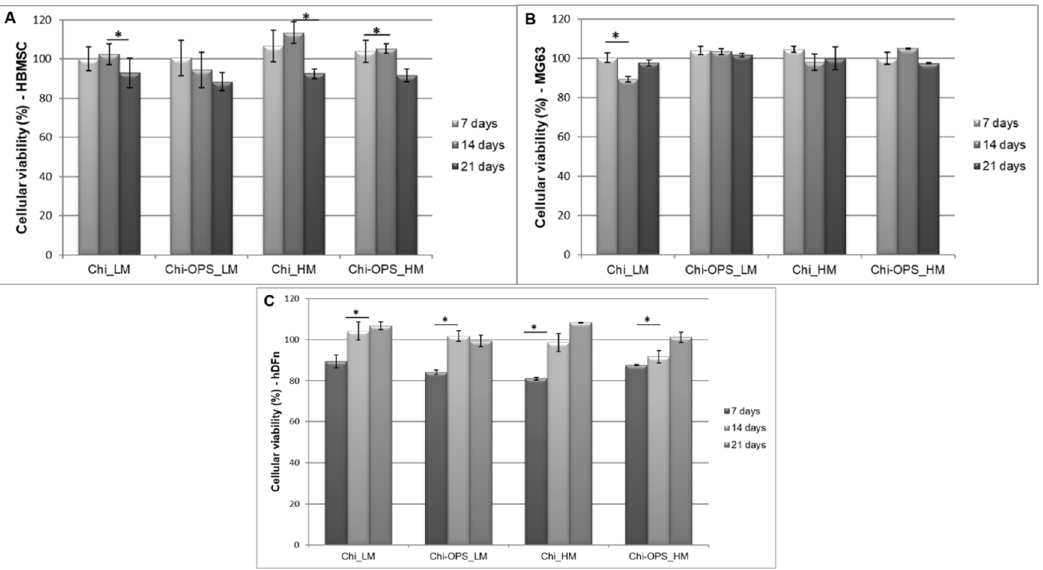
Figure 3. Fluorescent responses of primary cells cultured (HBMSC— A ), and both cell line cultured (MG63— B and HDFn— C ) incubated with CdS QD_Chi and QD_Chi–OPS (LM and HM) nanoparticles associated with the cellular metabolic. Cell culture control (TCPS) = 100%. Statistical analysis by one-way ANOVA, * p < 0.05.